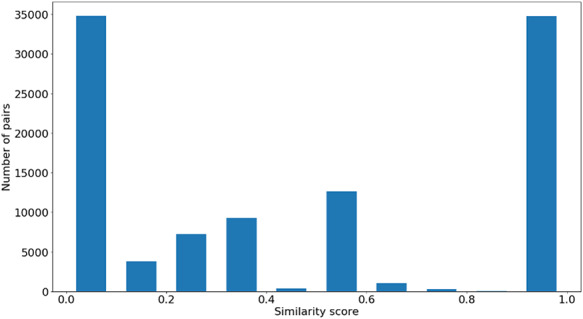
Distribution of \documentclass[12pt]{minimal}
\usepackage{amsmath}
\usepackage{wasysym}
\usepackage{amsfonts}
\usepackage{amssymb}
\usepackage{amsbsy}
\usepackage{upgreek}
\usepackage{mathrsfs}
\setlength{\oddsidemargin}{-69pt}
\begin{document}
}{}${\rm{si}}{{\rm{m}}_{{\rm{Pfam}}}}$\end{document} values across all species’ protein pairs in the protein family data sets.